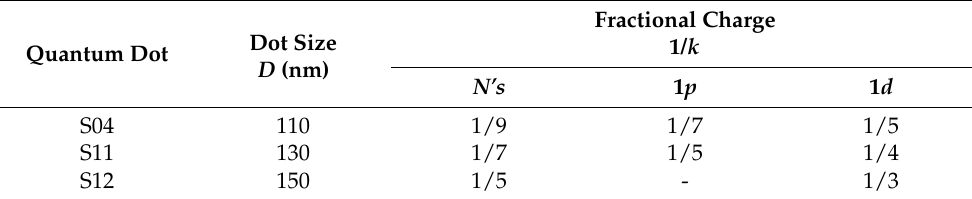
Figure 6. Number of vortexes (circles) versus dot size. Inserts show electron densities and vortex arrangement for 1 s (upper, D = 110, 130 and 150 nm), 2s (lower left, D = 150 nm), 1 p and 1 d (right, D = 130 nm). Solid lines outline linear approximation of k ( D ), dashed lines show k = 2 (horizontal) and critical D for vortex formation (vertical). Table 2. Measured fractional charge of single electron states.